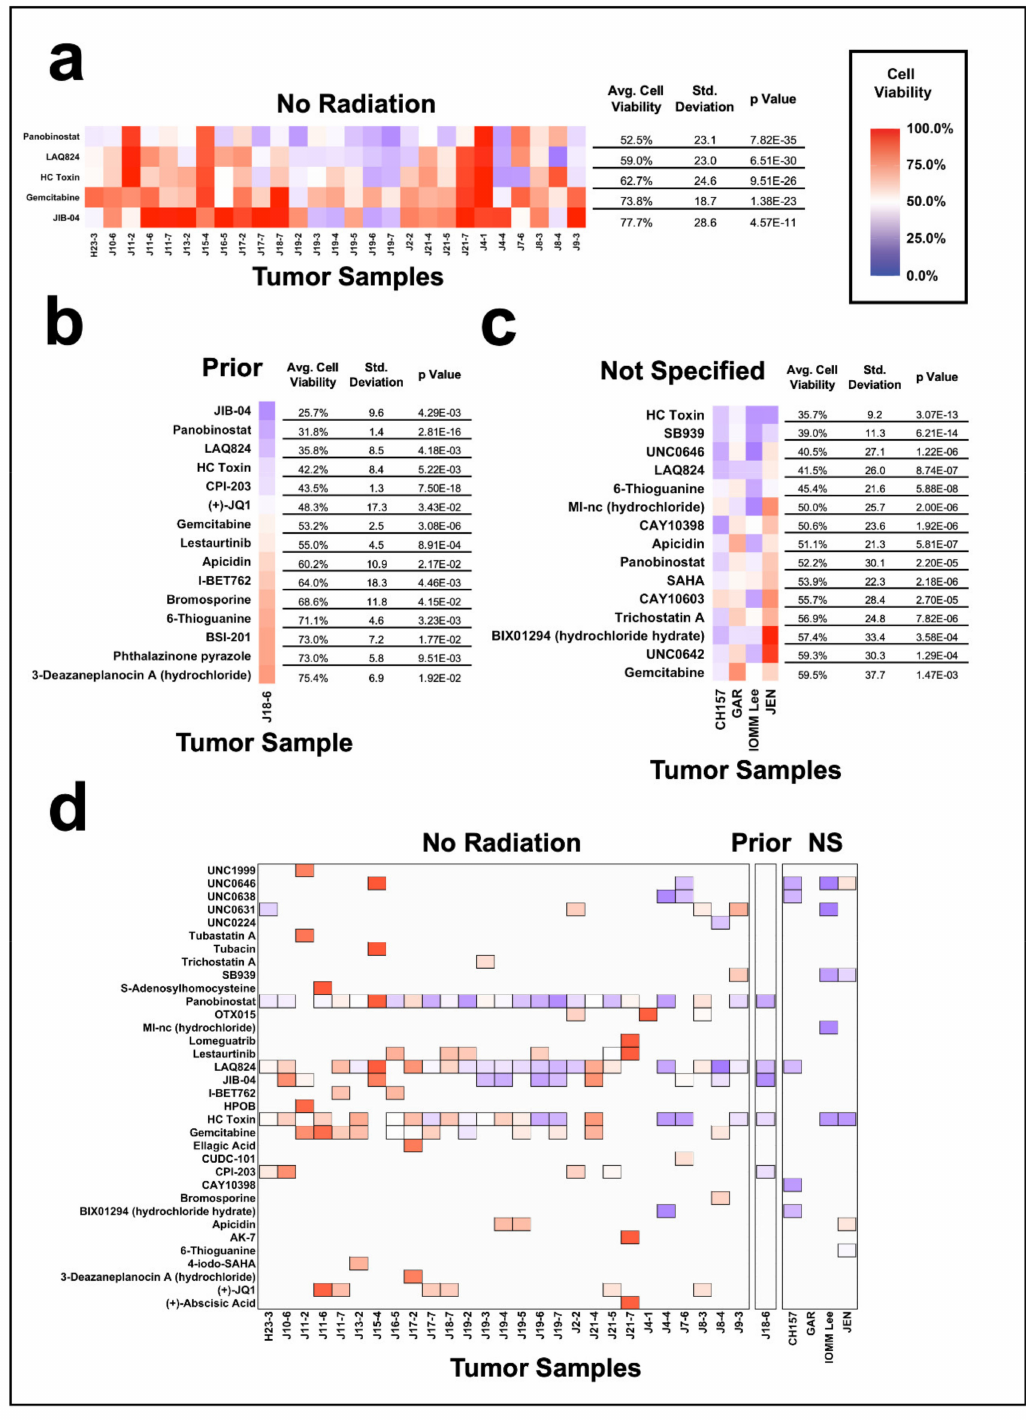
Figure 5. Comparison of the meningioma cohort by history of tumor radiation. Heat maps displaying the broadly most effective compounds for meningiomas with ( a ) no history of radiation, ( b ) prior history of radiation (denoted as “Prior”), and ( c ) tumors with a non-specified history of radiation. Broadly effective compounds for tumors with no radiation, prior radiation, or non-specified radiation are identified as compounds that reduce the average cell viability of the group to 80% or less and have a p value of less than 0.05. Heat maps were limited to the top 15 most effective compounds when applicable. ( d ) Heat map of the top five most effective epigenetic compounds, facetted by meningiomas with no radiation, non-specified history of radiation (denoted as “NS”), and tumors with prior radiation (denoted as “Prior”). The top five compounds are displayed as filled tiles in the heat map, while compounds that were not in the top five remain as white